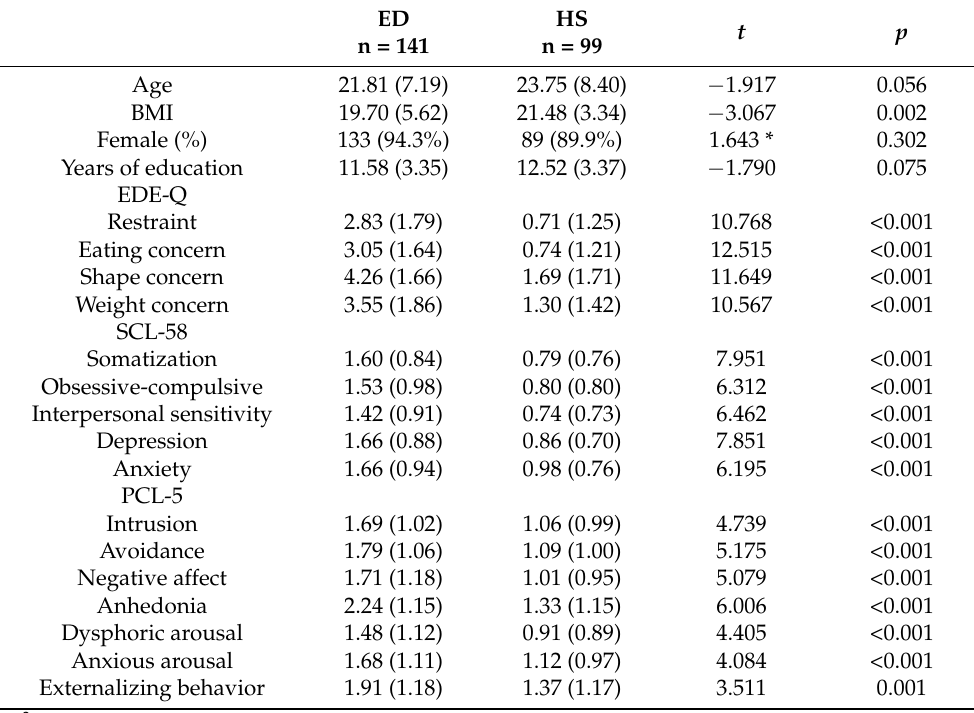
Table 1. Demographic characteristics of the